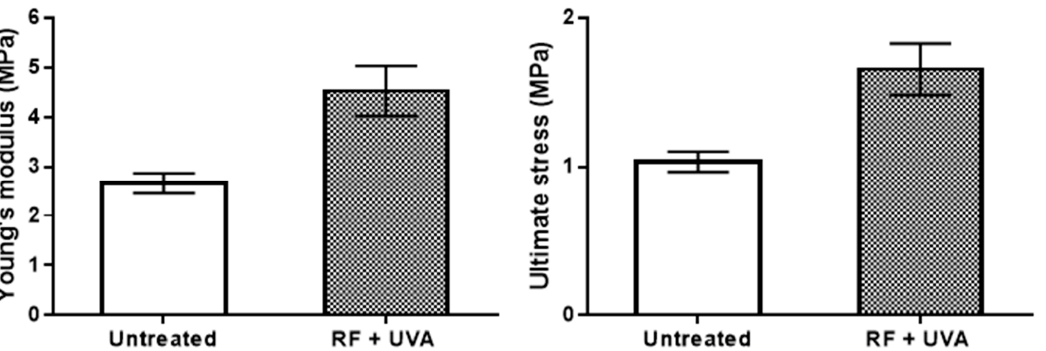
Figure 4. Mechanical properties of isolated porcine aortic adventitia. The differences between UV- treated (365 nm, 45 mW/cm 2 , 10 min) and untreated specimens were significant at a level of less than 0.15% ( p = 0.0012 for modulus, p = 0.0015 for stress), for n = 30. The effect of the crosslinking process was further assessed by measuring quantita- tively the weight loss caused by the in-vitro collagenolytic degradation in the untreated samples, and in the UV-irradiated samples. As seen in Figure 5, the exposure to UV-A radiation was able to stabilize the adventitial tissue against enzymatic degradation. In a separate experiment, chemical crosslinking with formaldehyde resulted also in the en- hancement of proteolytic resistance, the weight loss being ~3 times less than that recorded